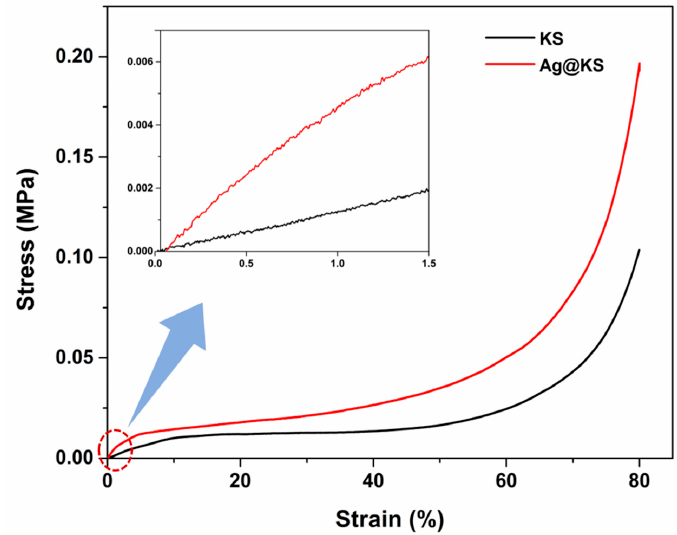
Figure 5. The compressive stress–strain curves of the KS and Ag@KS sponges (the initial linear re- gion is inserted). is